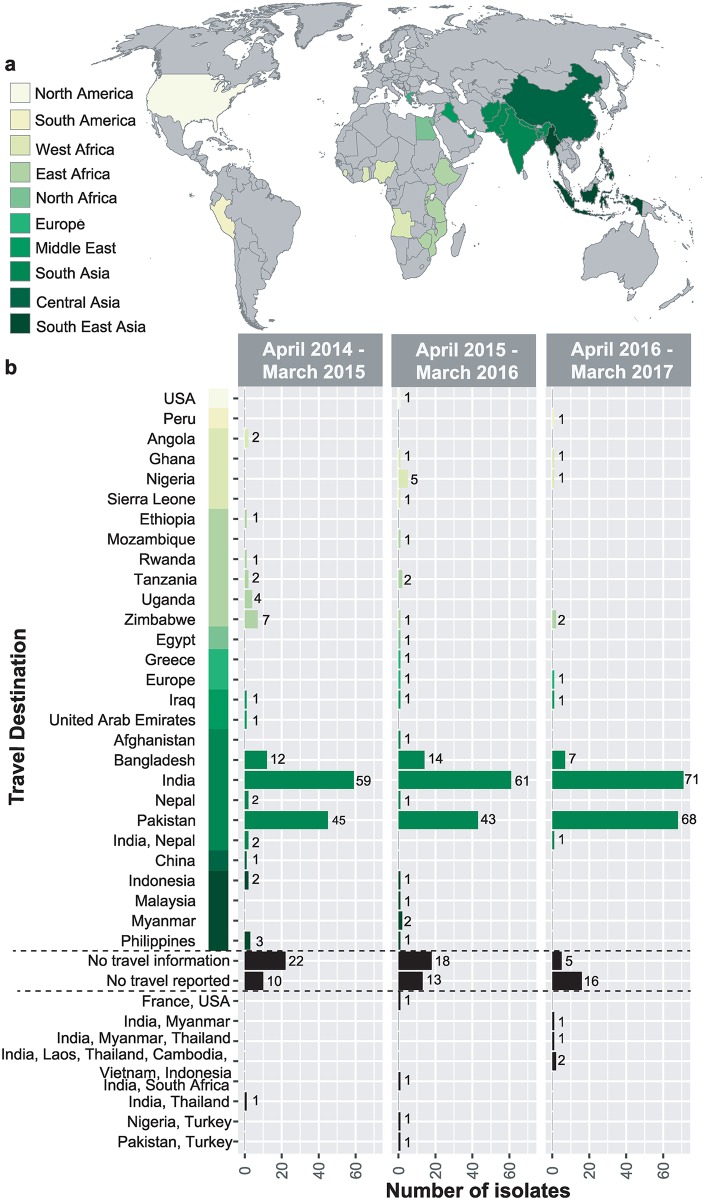
Summary of S. Typhi received at Public Health between April 2014 to March 2017.a) Map highlighting countries that were reported as travel destinations for patients from which S. Typhi cultures were collected. Countries are coloured by major geographical regions. Blank map sourced from https://commons.wikimedia.org/wiki/File:BlankMap-FlatWorld6.svg b) Number of S. Typhi isolates reporting travel to each country over the three-year period of study, stratified by date of receipt at PHE.